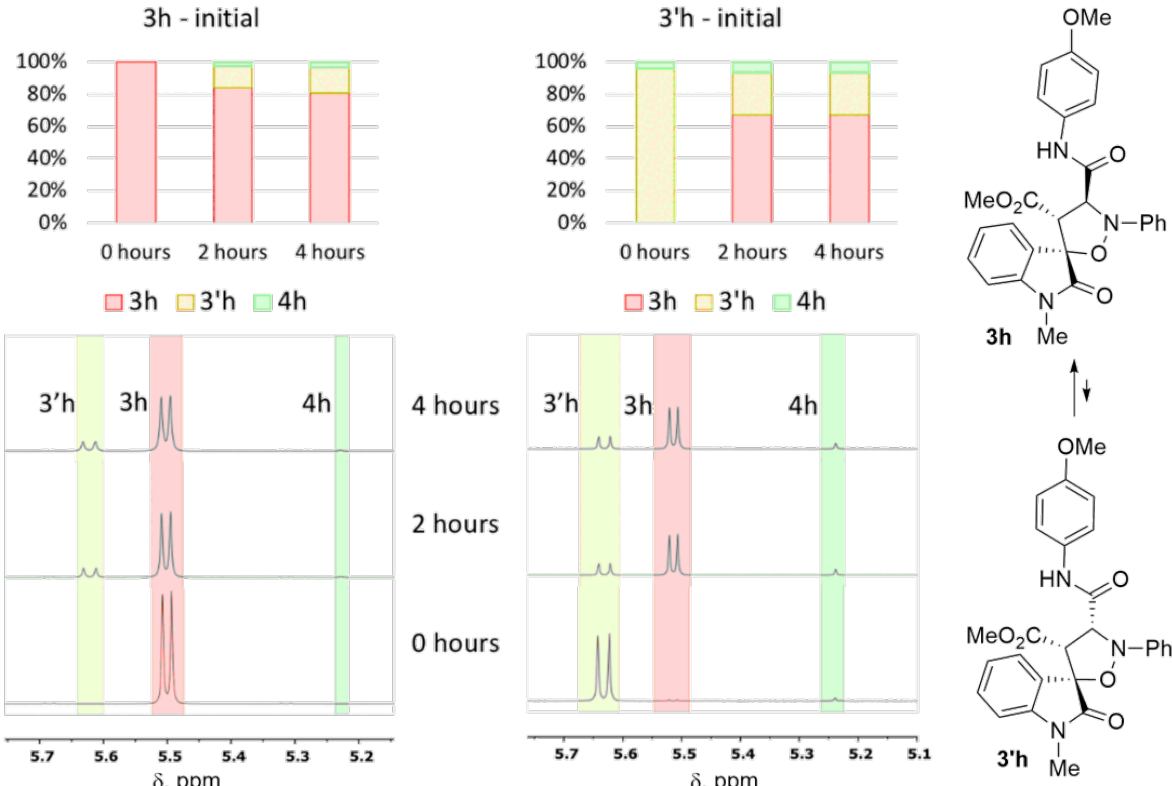
Figure 2. 1 H NMR monitoring of thermal interconversion between isoxazolidines 3h and 3 ′ h .